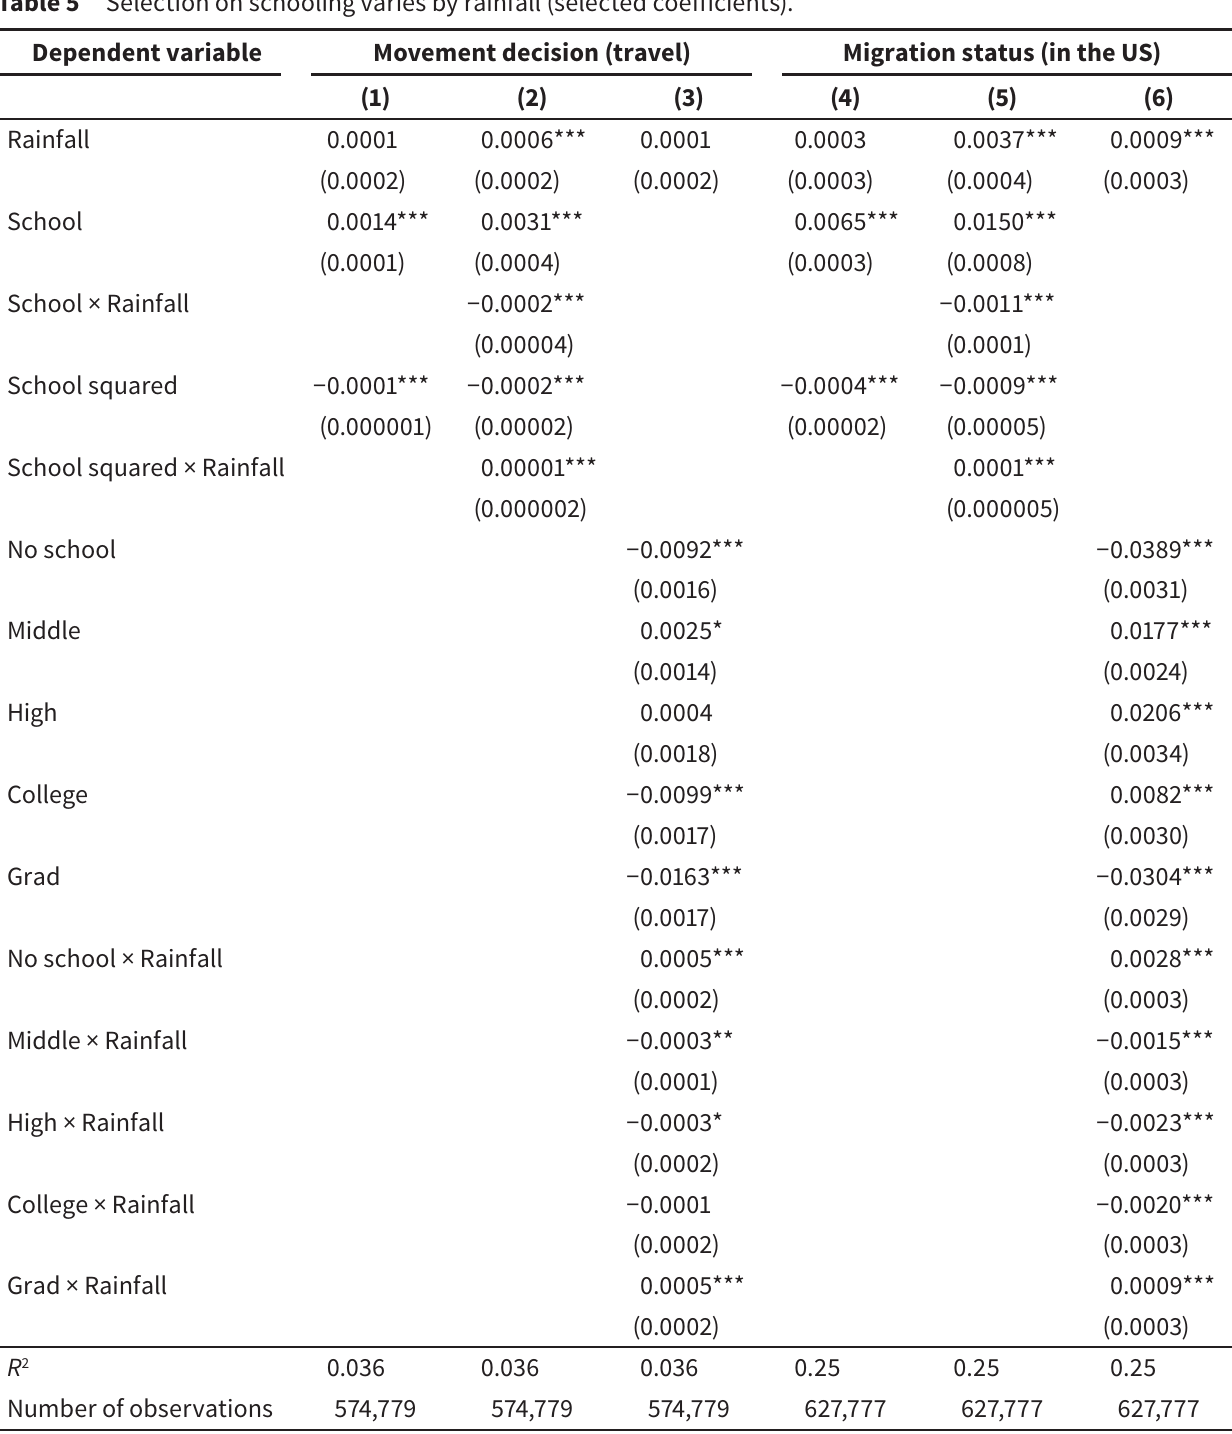
Selection on schooling varies by rainfall (selected